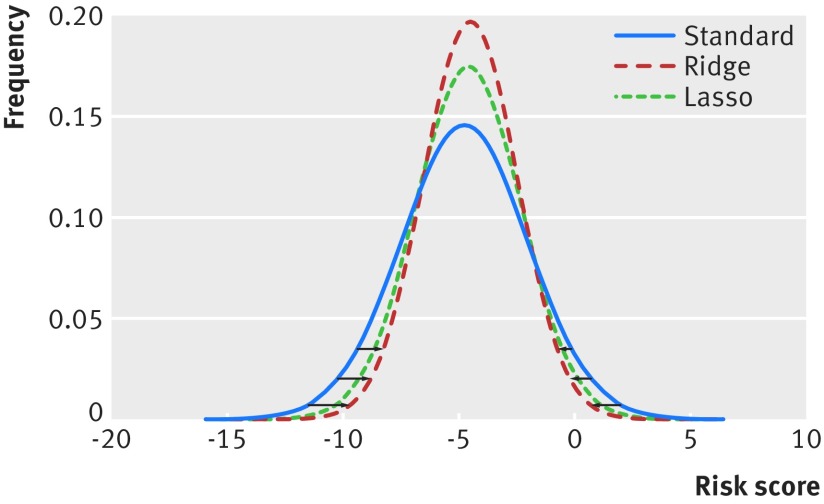
Fig 1 Distribution of predicted risk scores estimated using standard, ridge, and lasso regression